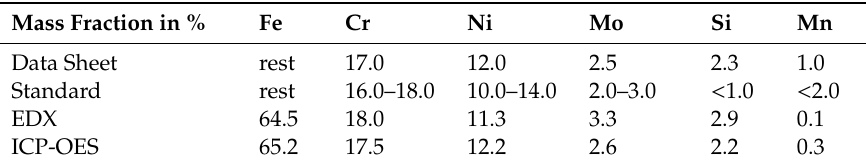
Table 3. Chemical composition of AISI 316L-Si powder (EDX) compared to chemical composition provided by supplier [11] and